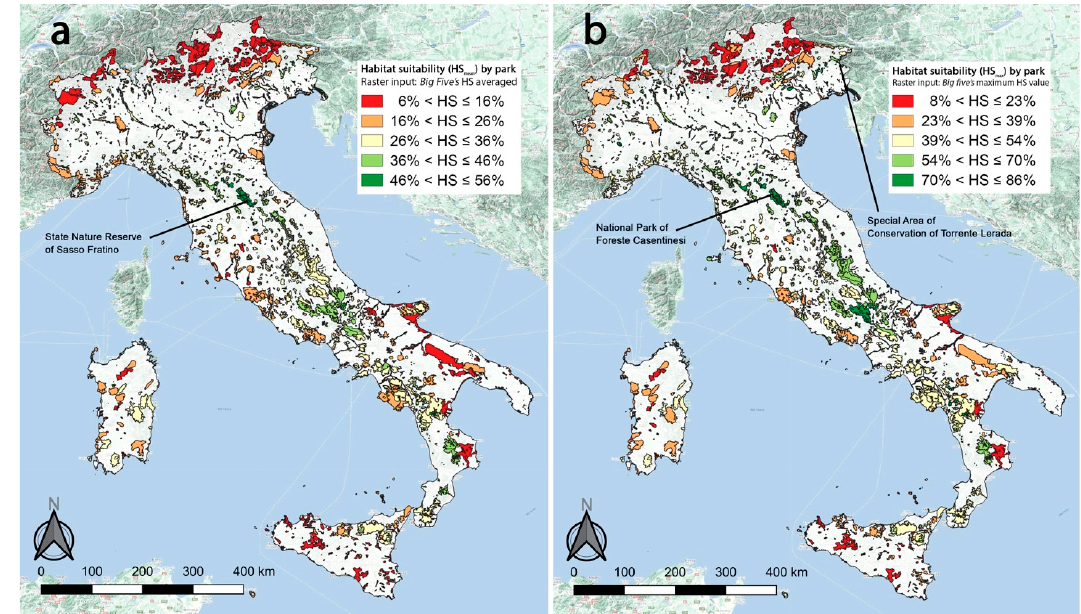
Figure 4. Maps showing the distribution of the Italian protected areas and their relevance for the conservation of big five ’s suitable habitat. In ( a ), each protected area was coloured according to the average HS mean value, dividing the range (min–max) in five HS levels: red = minimum, orange = low, yellow = medium, light green = high and dark green = optimal HS. In ( b ), the shape of each protected area was coloured according to the average HS max value, following the same ranking procedure. Average, together with median and maximum value, of both HS maps by protected areas were stored in supplementary material (Protected_areas_ITA_vector_layers.zip).